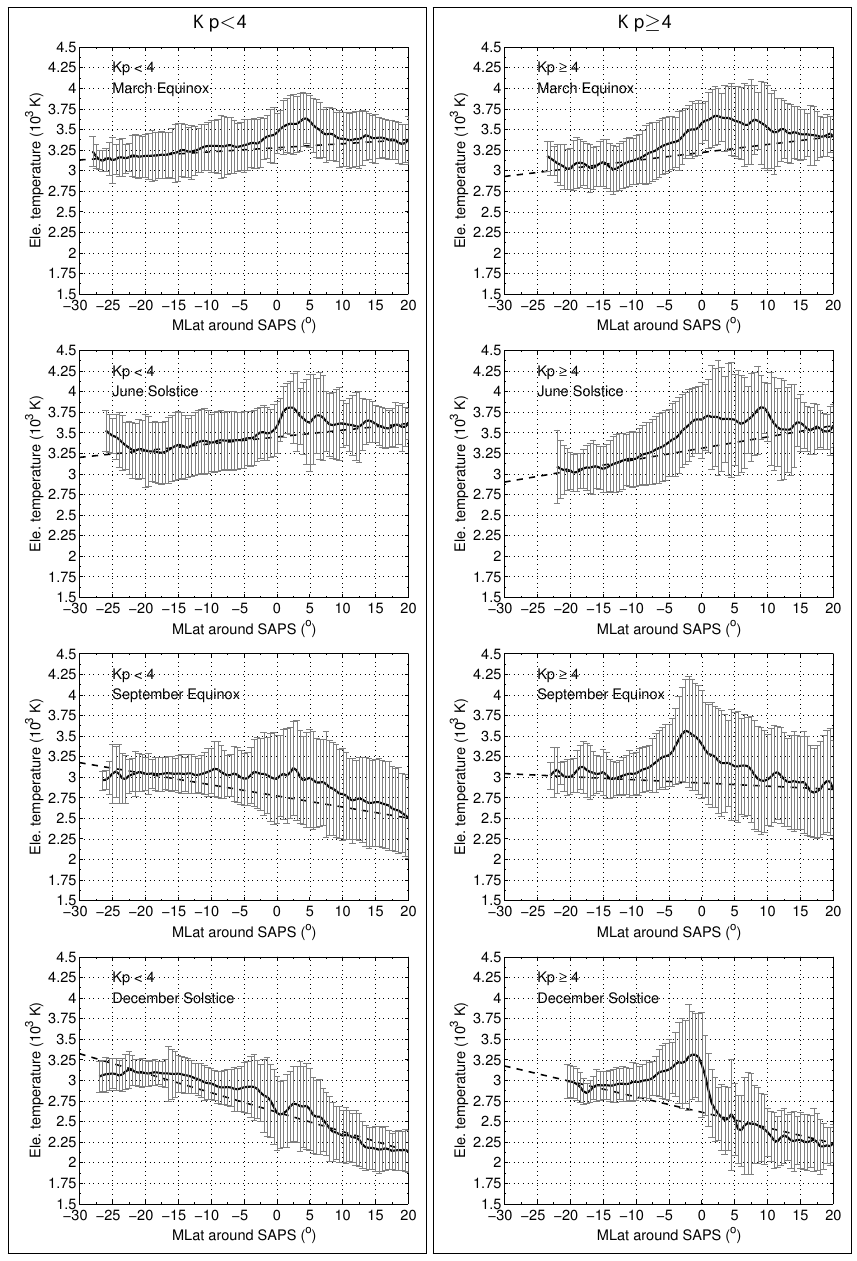
Fig. 6. The same as Figure 2, but for electron temperature. The background trend is indicated by a dashed line.